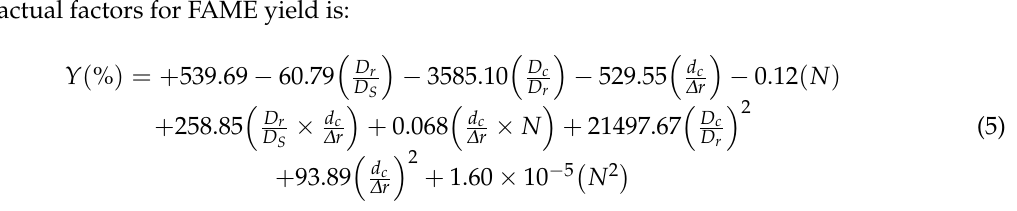
Figure 4. Perturbation of biodiesel yield versus independent variable deviation from reference point.